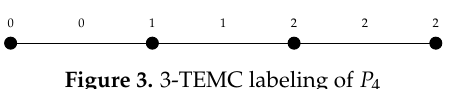
Figure 3. 3-TEMC labeling of P 4